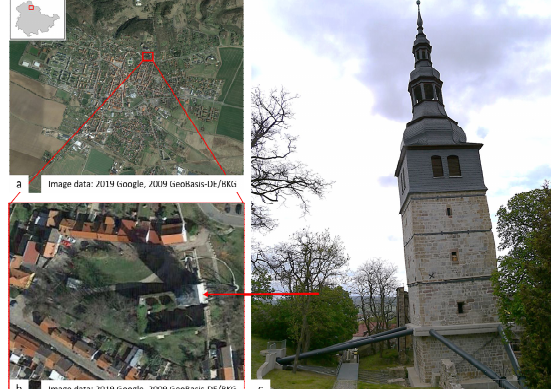
Figure 1: Overview of a) the city of Bad Frankenhausen; b) magnification of the image at the church location (Image data: 2019 Google, 2009 GeoBasis-DE/BKG); c) North view of the Church Tower